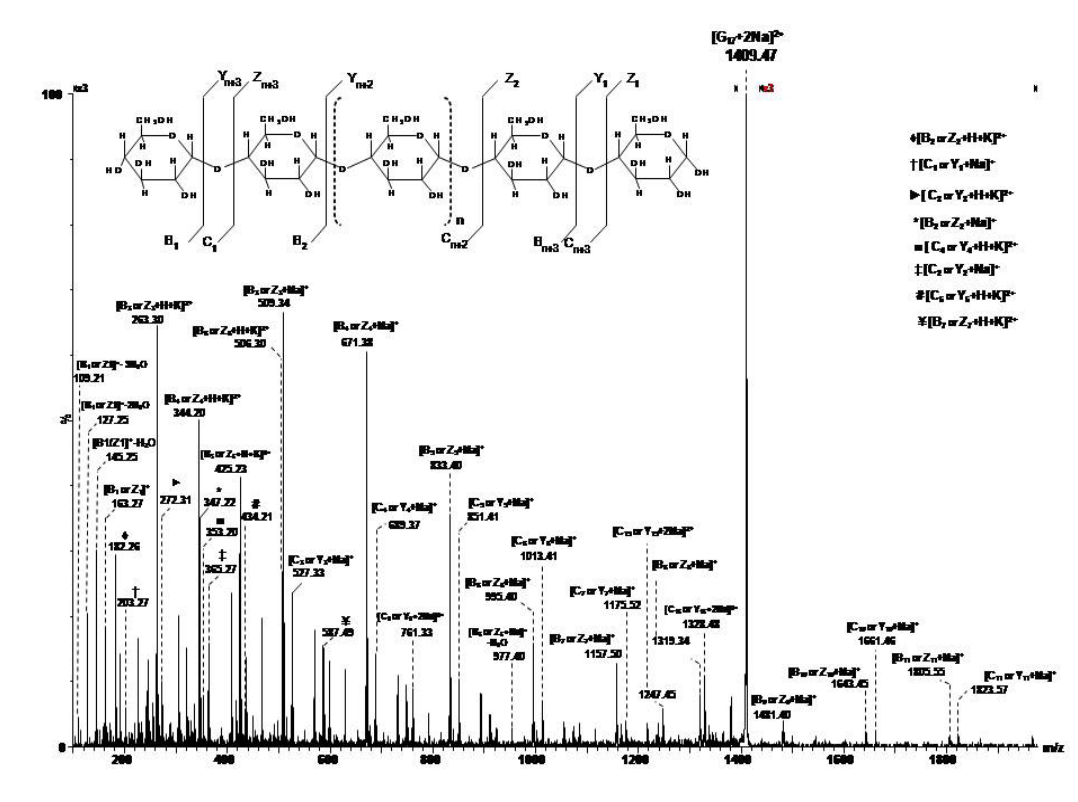
+2Na] 2+ in Dex 4. Cone voltage 50 V. Capillary voltage 17